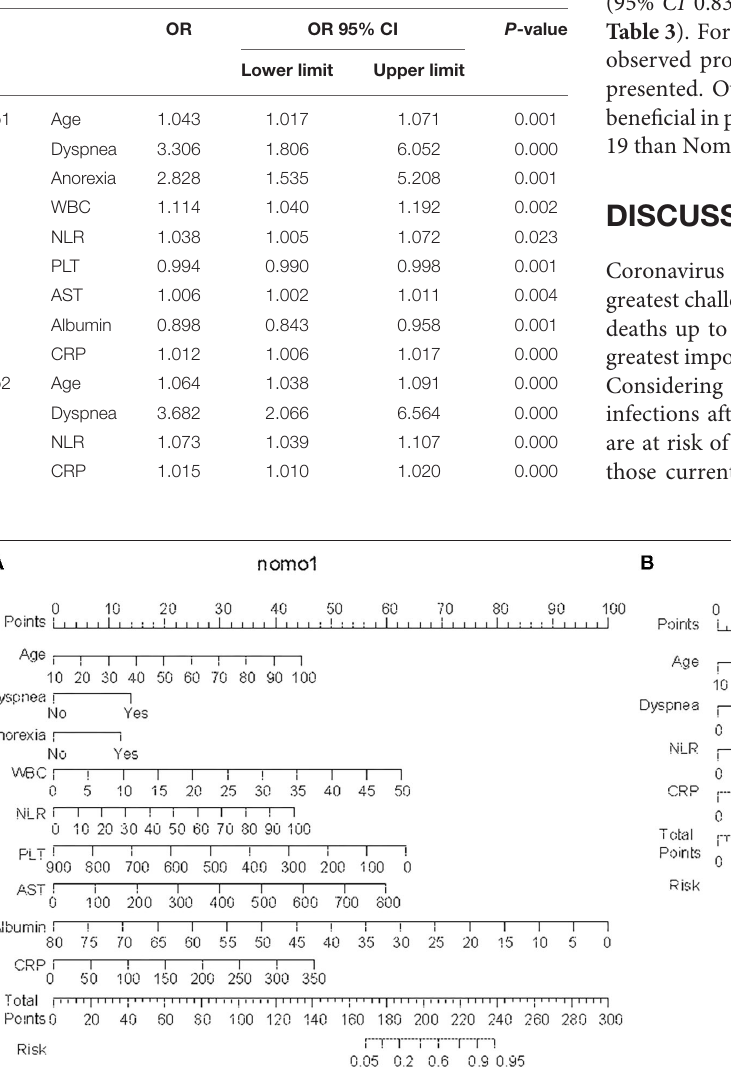
TABLE 2 | The multivariate logistic regression modes used to construct Nomo1 and Nomo2 ( N = 2,119).